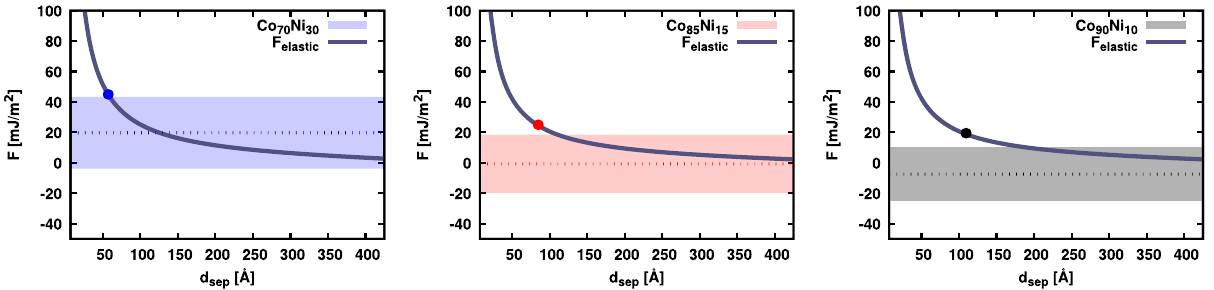
Fig. 4 Forces acting on Shockley partial dislocations during the dissociation process. The averaged SFE (dashed lines), local SFE (color blocks), and elastic interaction force per unit line (solid lines) are shown as a function of separation distance (d sep ). The local SFE blocks, which is plus/minus one standard deviation, can possibly intersect with the elastic interaction force curve as shown. Positive/zero/negative SFE are colored by blue/red/black, respectively. The circle dots are the averaged dislocation equilibrium separation distance from atomistic simulations after